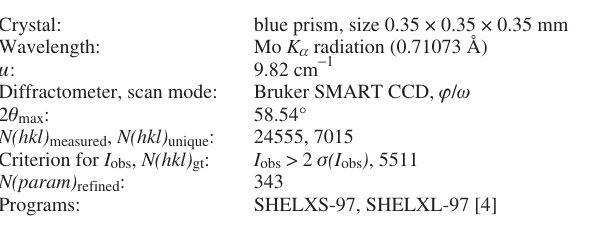
Table 1. Data collection and handling.